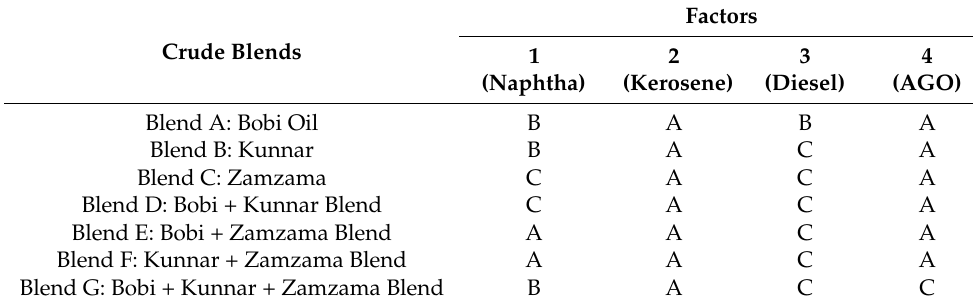
Table 6. Recipe for optimized cut points of seven crude blends [21] .